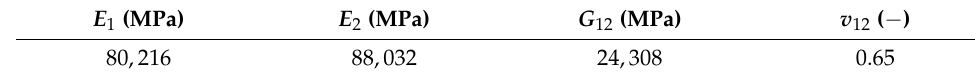
Table 8. 316L steel parameters necessary to carry out the FEM calculations.